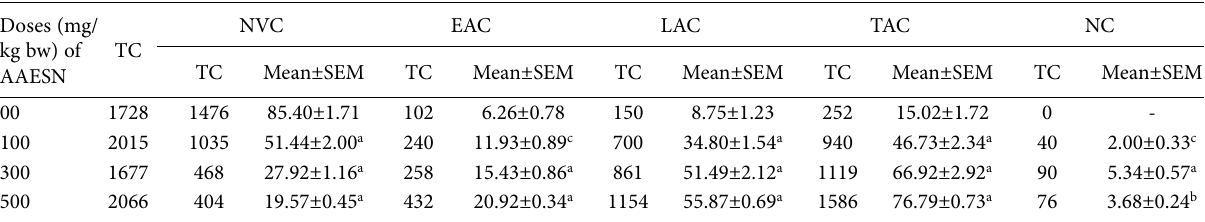
Table S2. Supplementary pooled data of Fig. 3 showing AAESN induced apoptosis and necrosis in WRBMCs in vivo